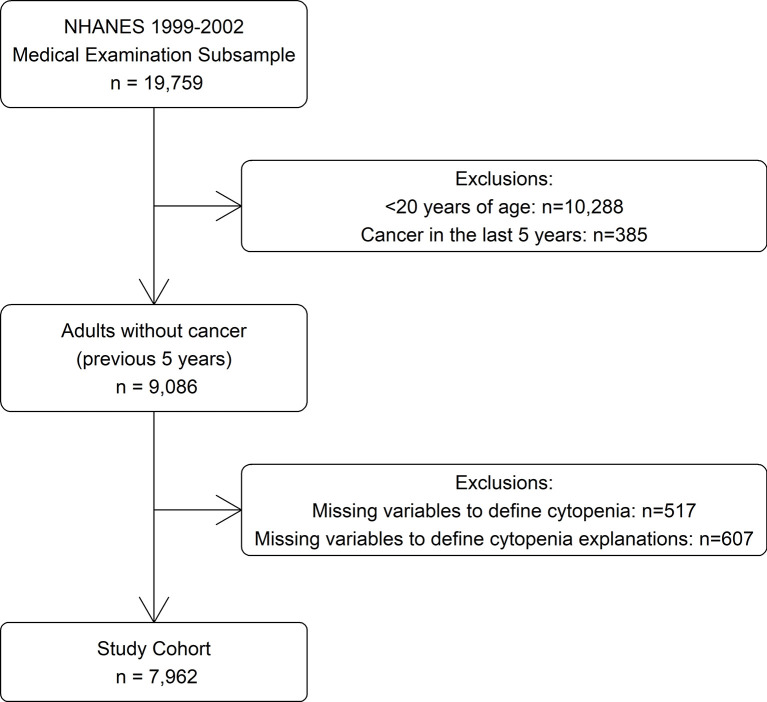
Selection criteria.